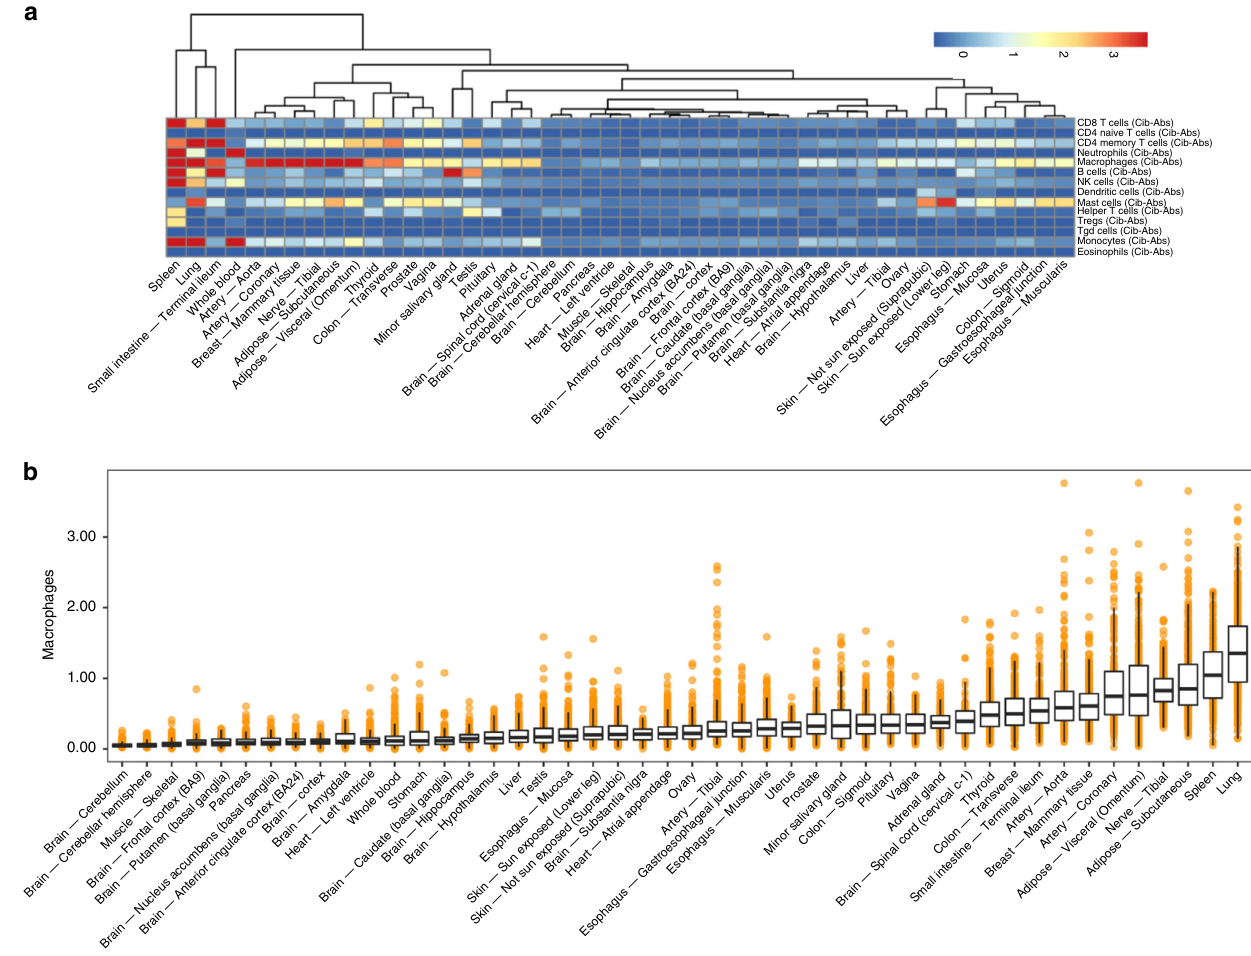
Fig. 2 Evaluating immune content across tissues. The quantity of 14 different immune cell types were estimated in GTEx samples using xCell, CIBERSORT-Absolute, and CIBERSORT-Relative deconvolution. a For CIBERSORT-Absolute, the median scores for each cell type were calculated within each tissue. Hierarchical clustering was performed on tissues. The dendrogram and standardized median cell type scores were visualized in a heatmap. b CIBERSORT-Absolute macrophage scores were plot for n = 11,141 samples across 46 tissue types. The tissues were sorted by median score. Data is summarized as boxplots where the middle line is the median, the lower and upper hinges represent the fi rst and third quartiles, and the whiskers extend from the hinge with a length of 1.5x the inter-quartile range. All data points are plot individually. Source data are provided as a Source Data fi